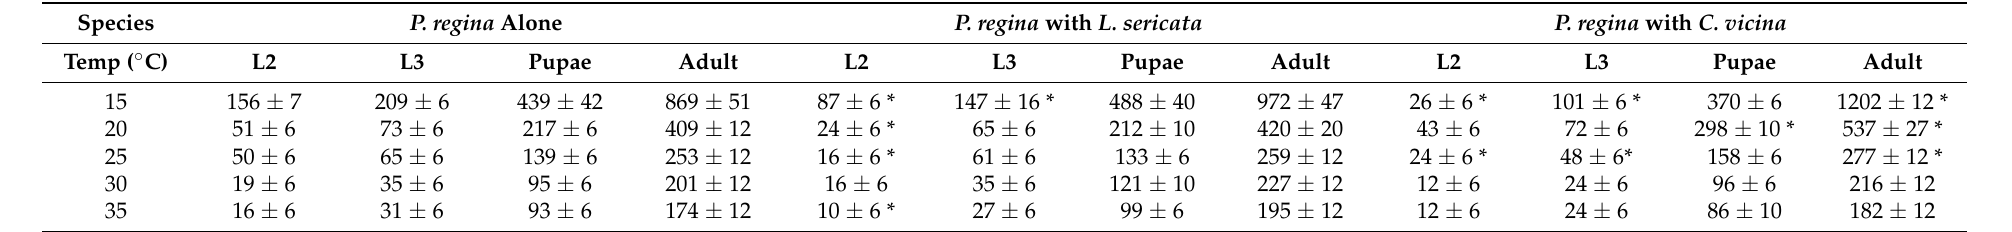
Table 2. Mean minimum development times (h) to reach each life stage starting from 1 h old first instar larvae for P. regina when developing with conspecifics ( P. regina alone) and heterospecifics ( P. regina with L. sericata or with C. vicina ). Variation around the mean is presented as the greater of either half the sampling interval (6 h for second instar to pupal stages, 12 h for adult stage) or the calculated standard error. Asterisk * indicate differences ( p ≤ 0.003) between P. regina alone and with L. sericata combinations, or with C. vicina combinations within a single stage and temperature pairwise